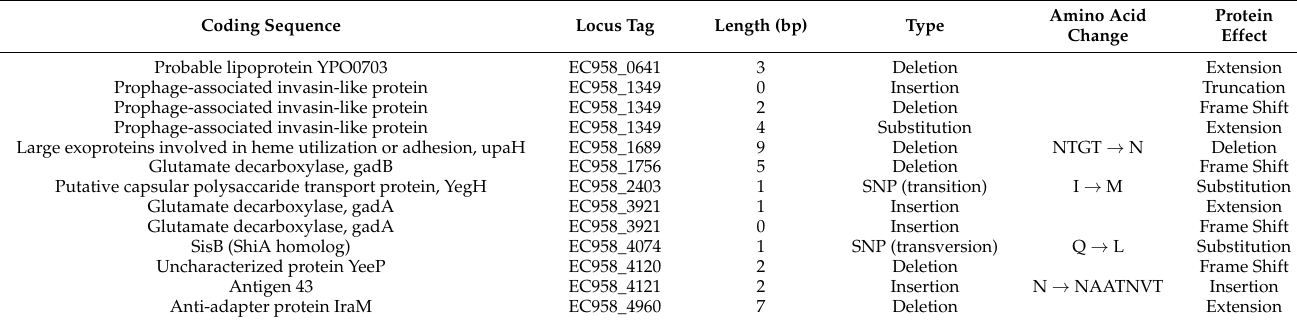
Table 2. Notable Mutations in UCS1.1 compared to